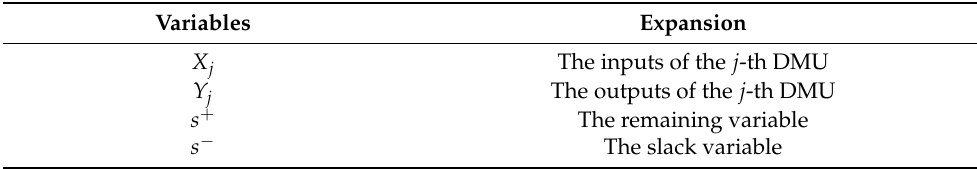
Table 3. The expansion of the model’s decision parameters. Parameters Expansion n The number of DMUs in the market m The number of inputs The number of outputs The weight coefficient vector of the